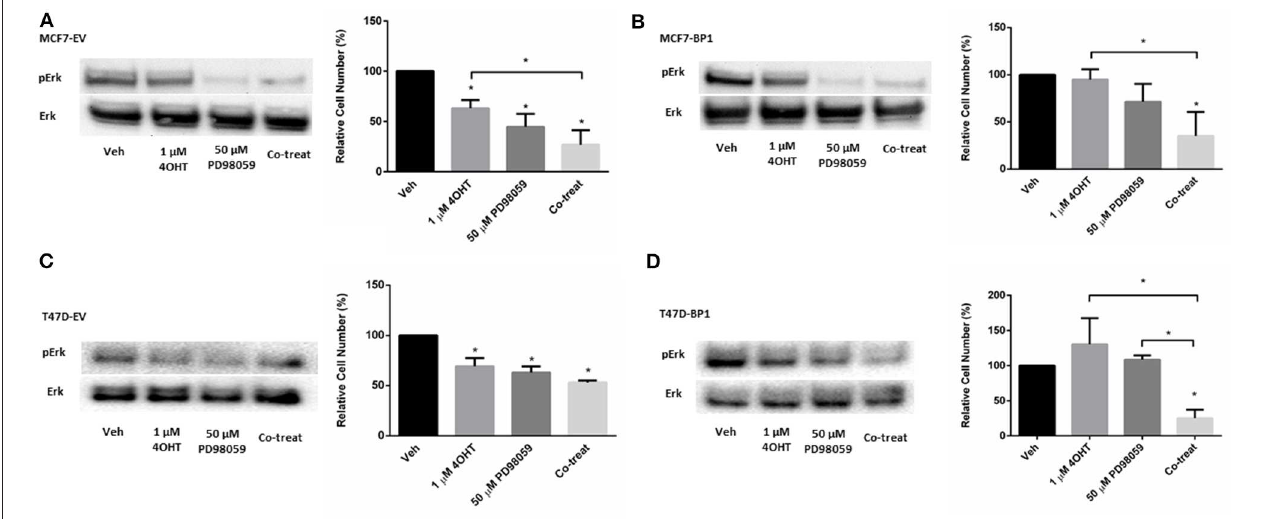
FIGURE 5 | MAPK inhibition reverses tamoxifen resistance in breast cancer cells. (A) Left: immunoblot analysis of phospho-Erk (pErk) of treated MCF7-EV; right: measurement of relative cell number (%) of MCF7-EV under different treatments for 5 days. (B) Left: immunoblot analysis of phospho-Erk (pErk) of treated MCF7-BP1; right: measurement of relative cell number (%) of MCF7-BP1 under different treatments for 5 days. (C) Left: immunoblot analysis of phospho-Erk (pErk) of treated T47D-EV; right: measurement of relative cell number (%) of T47D-EV under different treatments for 5 days. (D) Left: immunoblot analysis of phospho-Erk (pErk) of treated T47D-BP1; right: measurement of relative cell number (%) of T47D-BP1 under different treatments for 5 days. Results are the average of 3 independent experiments, and error bars are the standard error of the mean. * p <